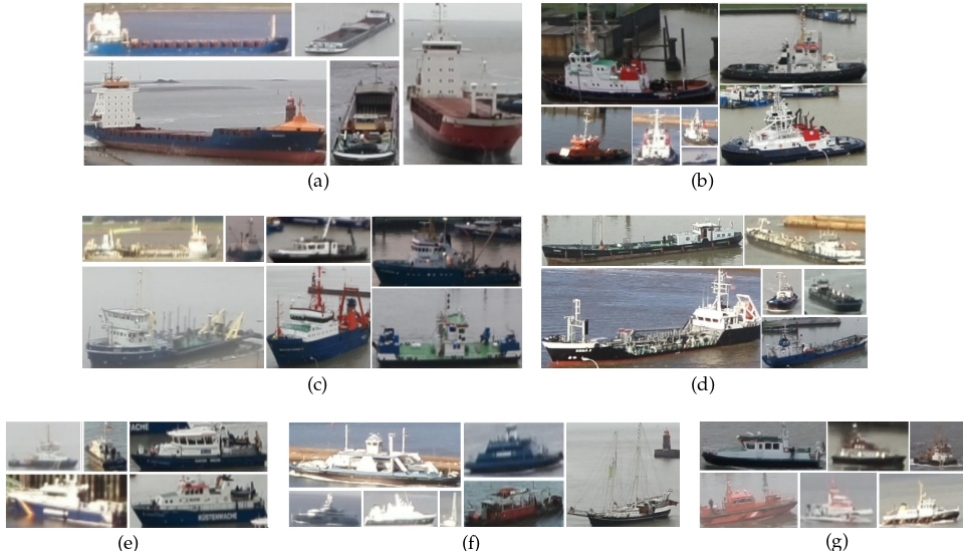
Figure 2. Examples extracted from the dataset that show the seven ship classes. Each class contains a variety of sizes and orientations of the ships. ( a ) Cargo , ( b ) Tug, ( c ) Special 1, ( d ) Tanker, ( e ) Law Enforcement, ( f ) Passenger/Pleasure, ( g ) Special 2.